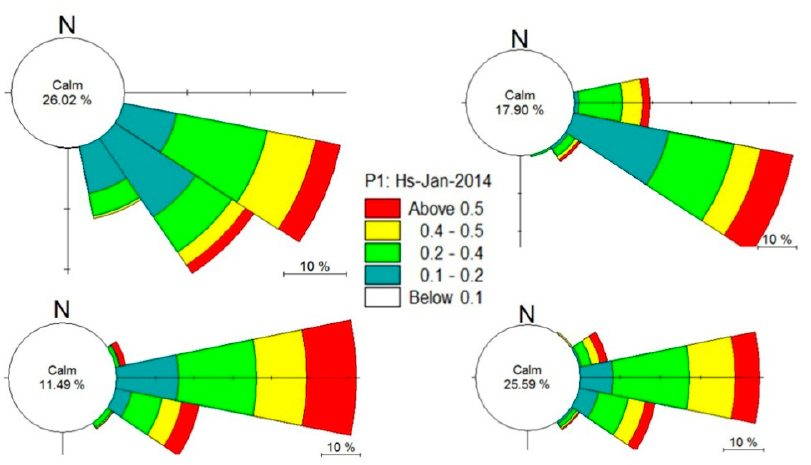
Figure 8. Wave rises at P1 ( up-left ), P2 ( up-right ), P3 ( down-left ), and P4 ( down-right ) at the Go-Cong area in the NE monsoon (January 2014).